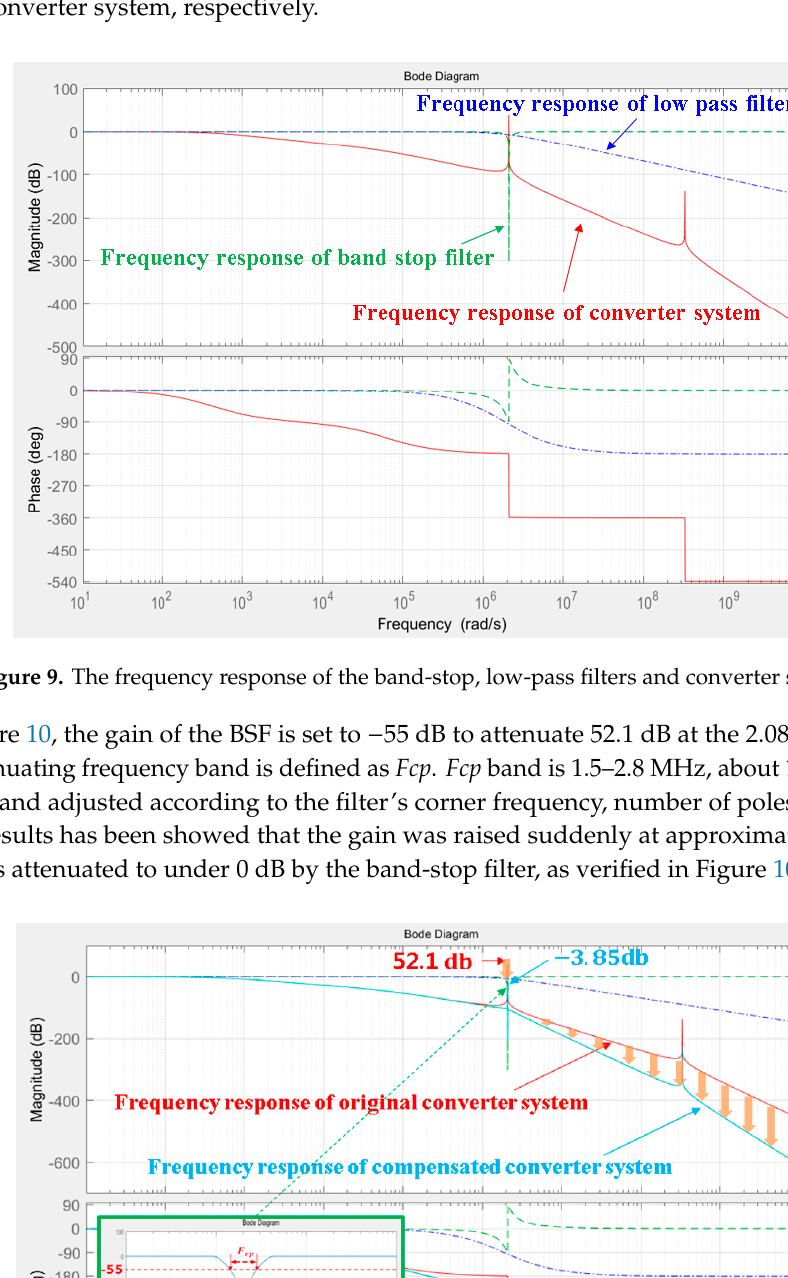
Figure 10. The comparison of the frequency response between the original converter system and the compensated system.